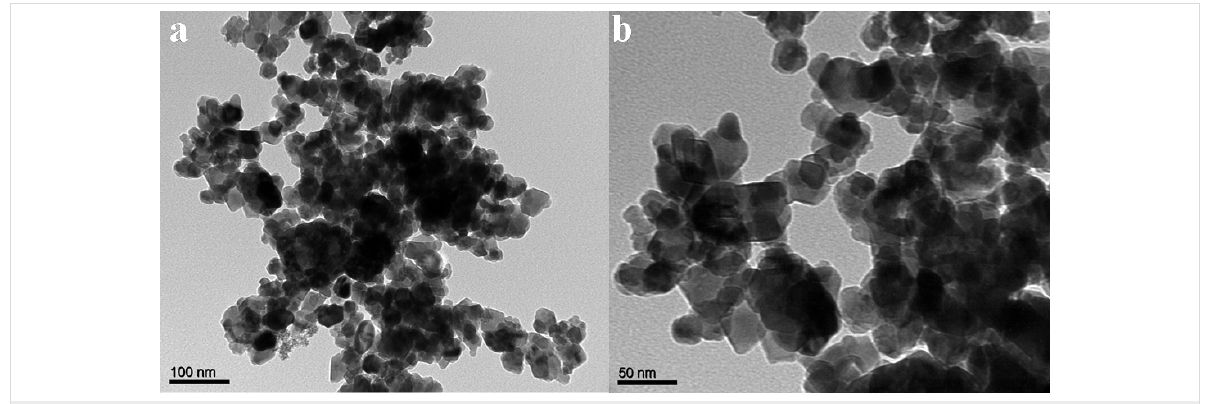
Figure 3: (a) TEM image and (b) magnified TEM image of ZFO-500.